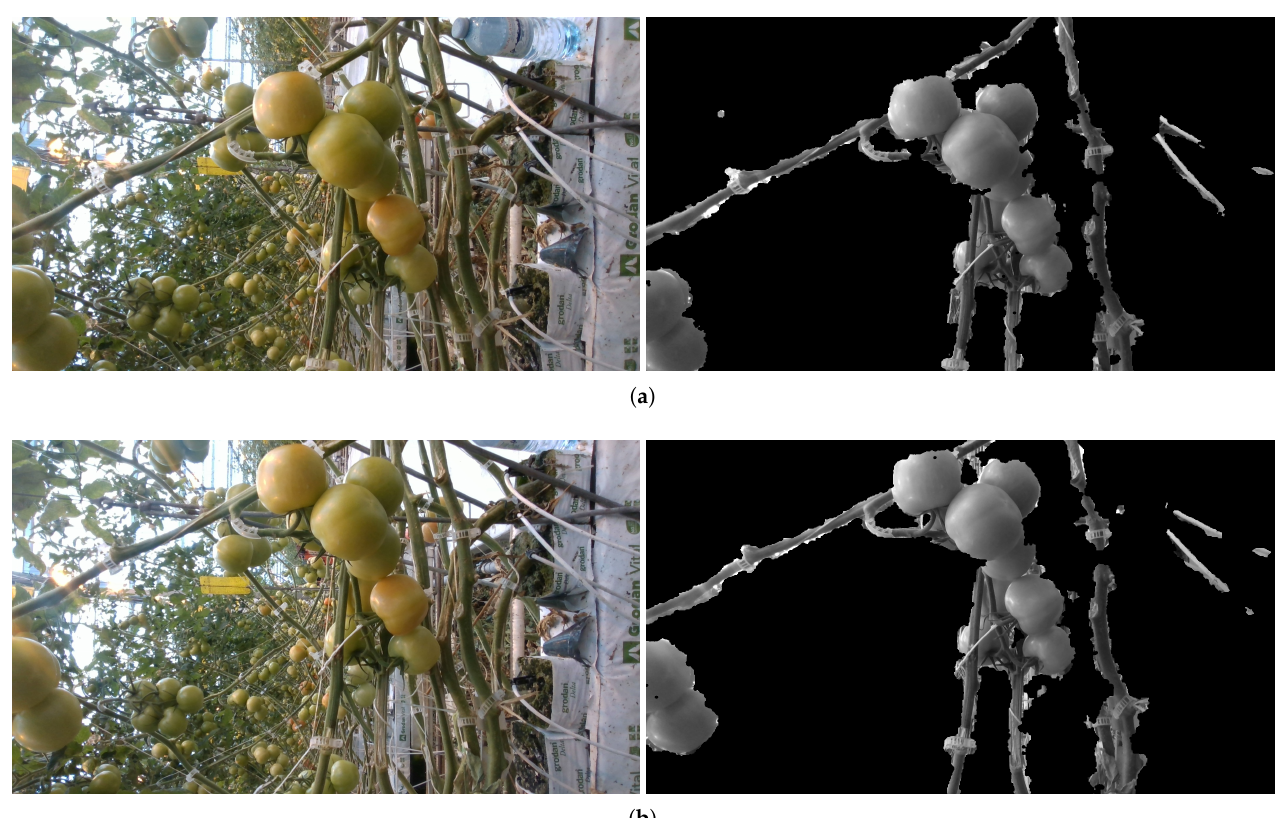
Figure 4. Two images of the row taken approximately 10 cm apart with backgrounds removed on the right. ( a ) First image. ( b ) Second image.